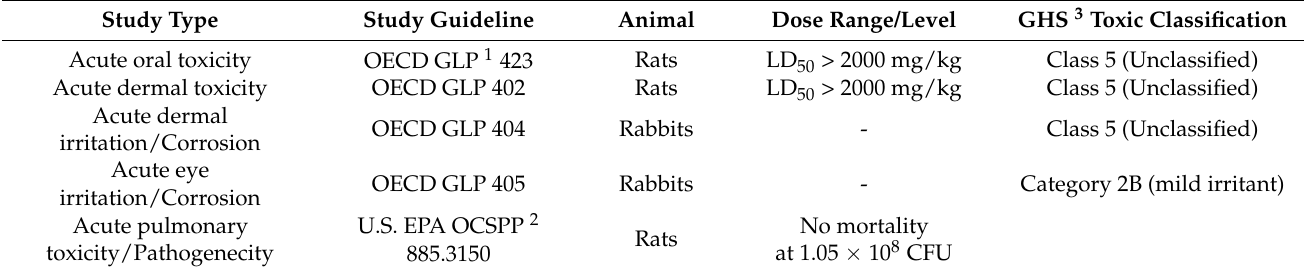
Table 3. Biosafety assessment of Metarhizium sp. BCC 4849 conidia in